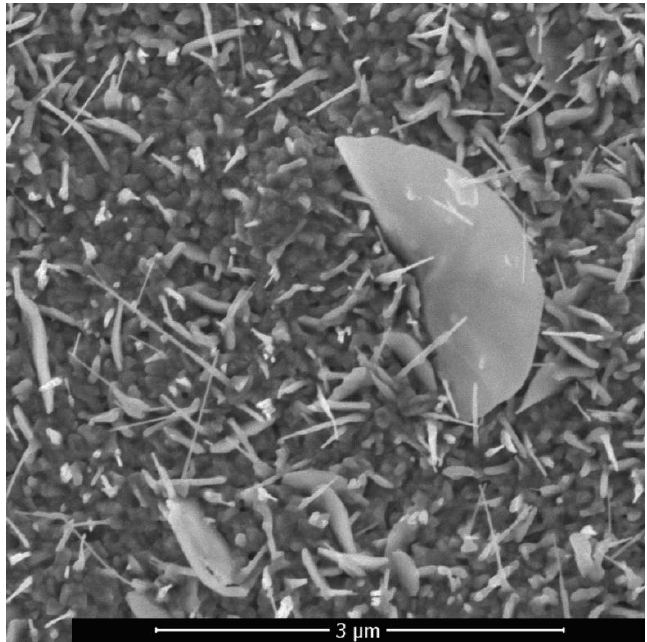
Figure 8. ZnO structure consisting of nanowires and nanosheets.